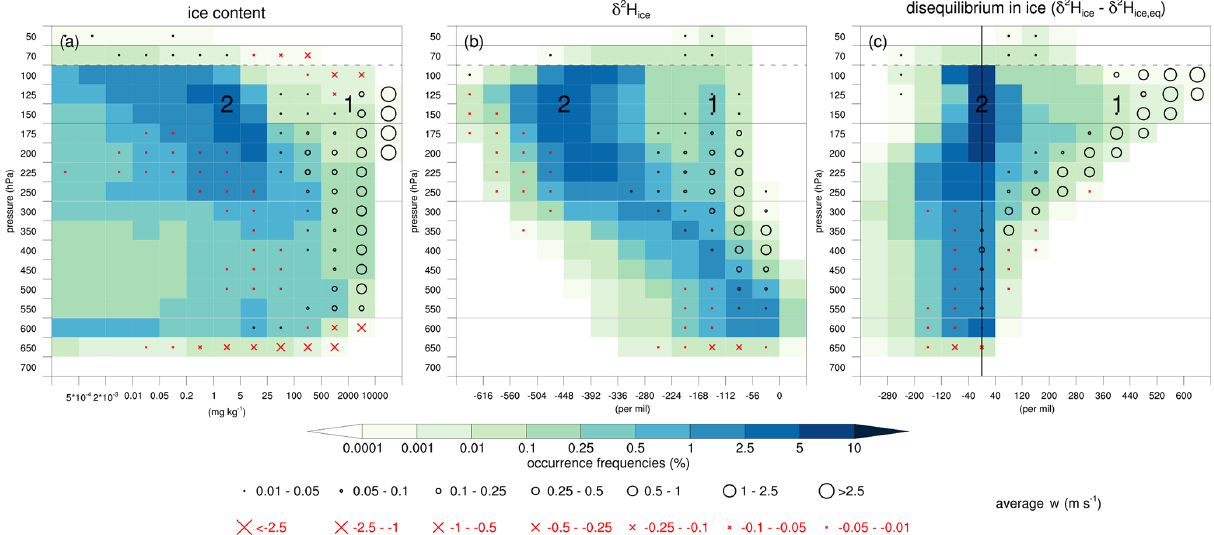
Figure 9. Frequency distribution of ice and its isotopic composition across pressure levels in the region of interest for July 2016. Frequency occurrences of (a) ice content (mgkg − 1 ), (b) δ 2 H in ice (‰), and (c) disequilibrium in ice (‰) are based on grid points with ice content ≥ 10 − 4 mgkg − 1 . Black circles (red crosses) denote the positive (negative) average vertical motion for the corresponding bins, as indicated by the legend, and are only plotted for bins where the frequency occurrences exceed 10 − 4 %. The labels (1) and (2) in the panels refer to the processes discussed in the